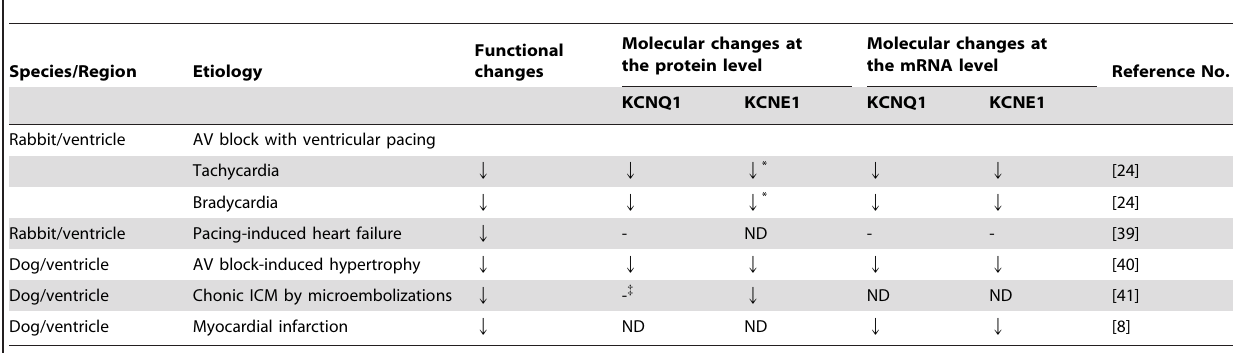
Table 5. Divergent molecular mechanisms for potassium channel remodeling in animal models of heart disease.